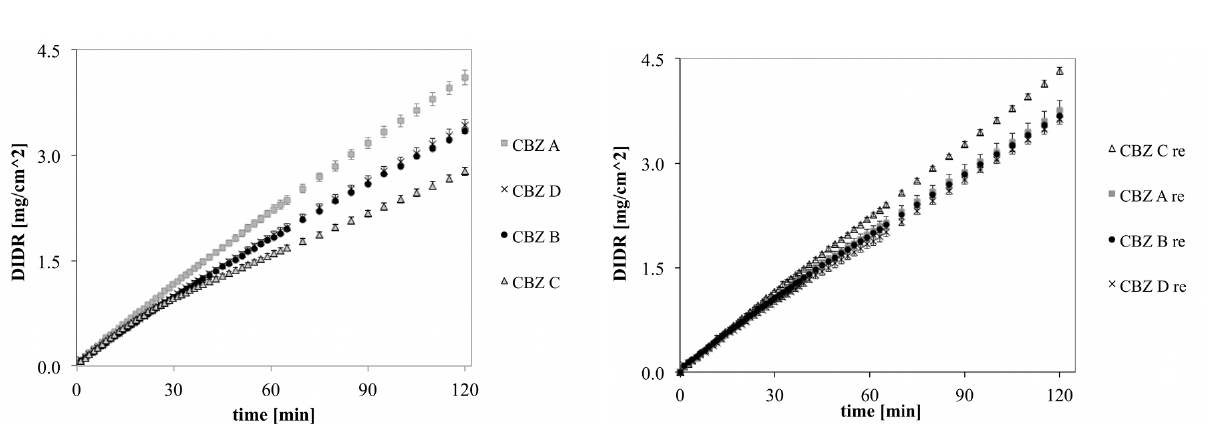
Figure 6. DIDR profiles of untreated (left) and recrystallized (right) CBZ A, B, C and D; 2 h DIDR test. Average values (n ≥ 3) are presented.